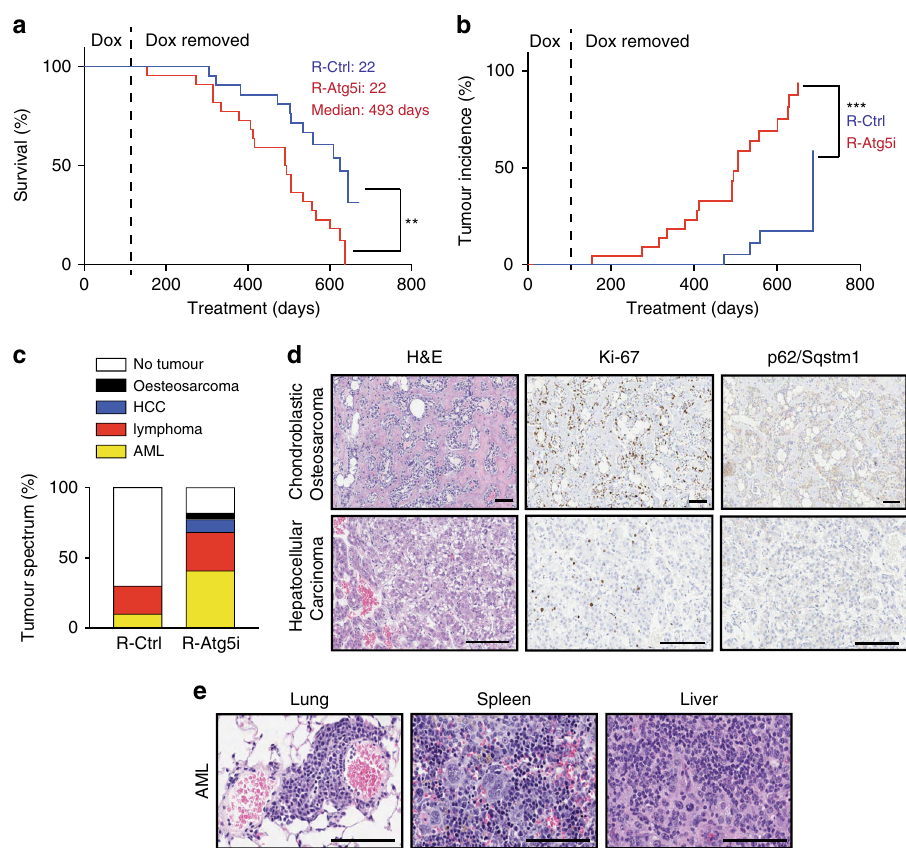
Fig. 6 R-Atg5i mice are associated with accelerated spontaneous tumour development. a R-Atg5i mice on display a reduced lifespan in comparison to R-Control mice ( p < 0.01). b Increased frequency of spontaneous tumour formation in R-Atg5i cohorts ( p < 0.001). c Tumour spectrum in R-Atg5i mice versus R-Control mice. d , e Examples of R-Atg5i tumour histology. H&E staining and immunostaining of indicated proteins. Scale bars, 100 μ